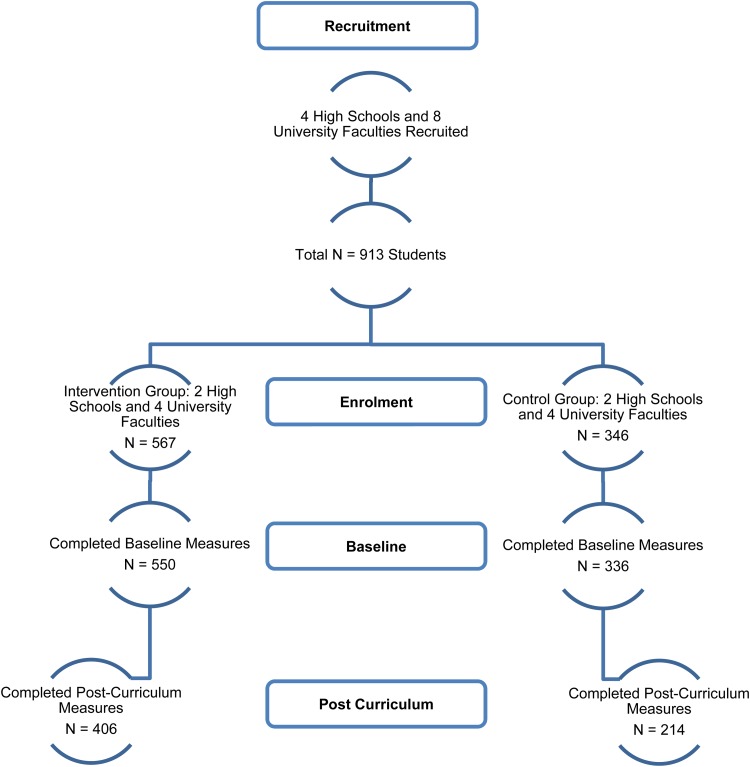
CONSORT Diagram.